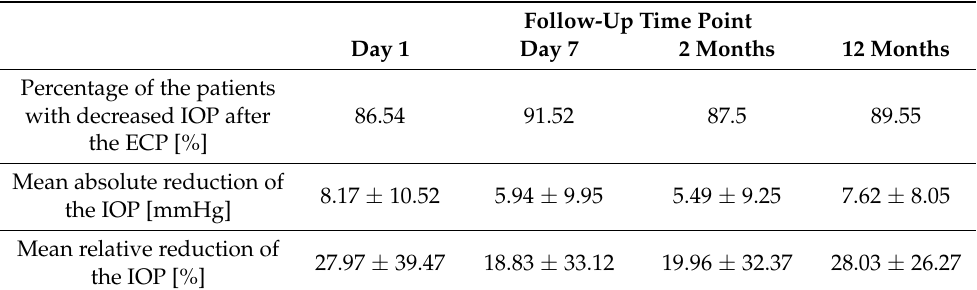
Table 2. Mean values of absolute and relative postoperative reduction of IOP depending on the time after endoscopic cyclophotocoagulation.